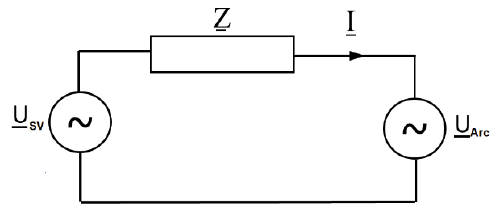
Figure 1. Simplified single-phase equivalent diagram of the arc device.